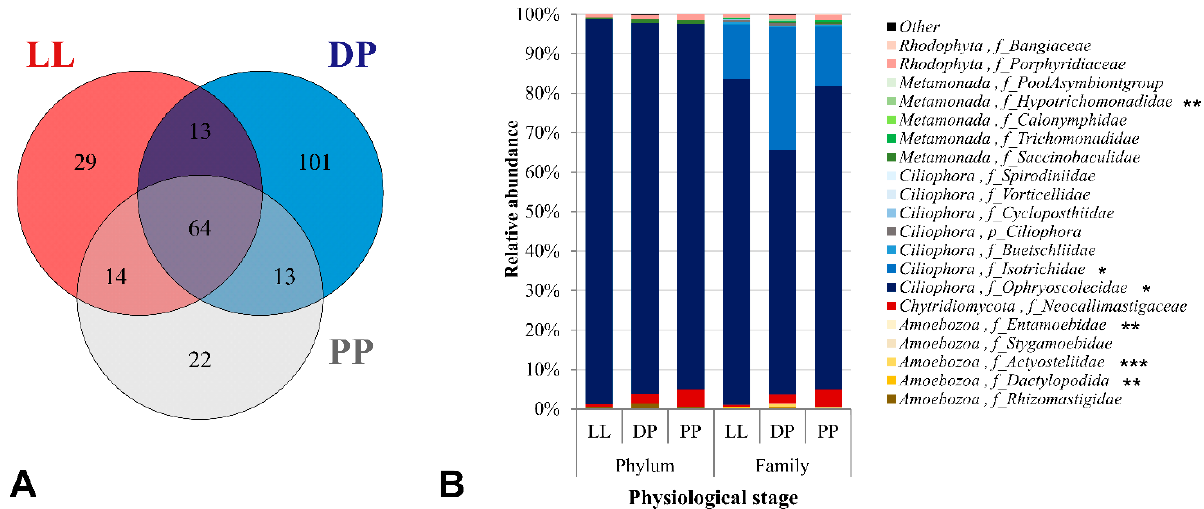
Figure 4. Distribution of eukaryotic-OTUs and active rumen eukaryotic taxa in different groups. ( A ) A total of 256 OTUs specific to the V9 region of eukaryotic 18S rRNA, identified during different physiological stages, were included in the Venn diagram and grouped as either unique or shared OTUs between the LL, DPs and PP microbiome. ( B ) Relative abundances of five eukaryotic phyla and 20 eukaryotic families are shown. Phyla with relative abundance <1% were grouped as “Other”. The significantly different bacterial taxa between physiological stages are indicated by p values (ANOVA). * p ≤ 0.05, ** p ≤ 0.01, *** p ≤ 0.001.